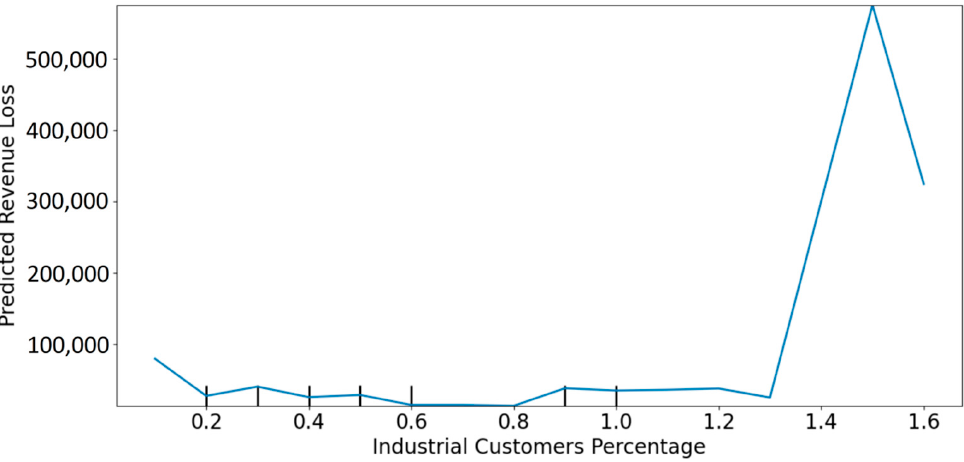
Figure 21. Influence of industrial customer percentage parameter on the revenue loss.